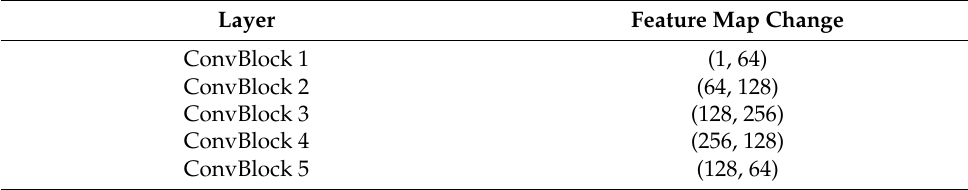
Table 2. Network structure.